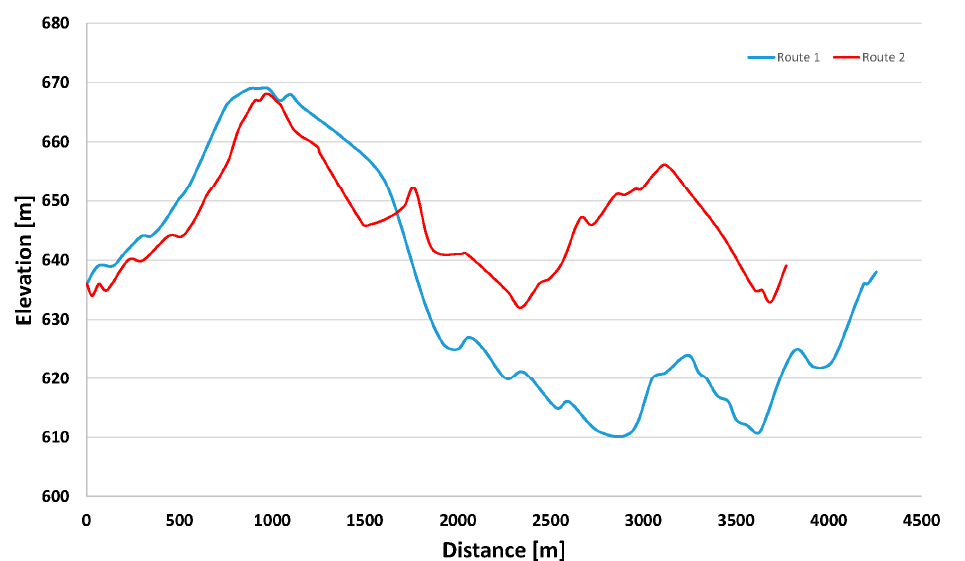
Figure 4. Height profile of the driving cycle for route 1 and 2.